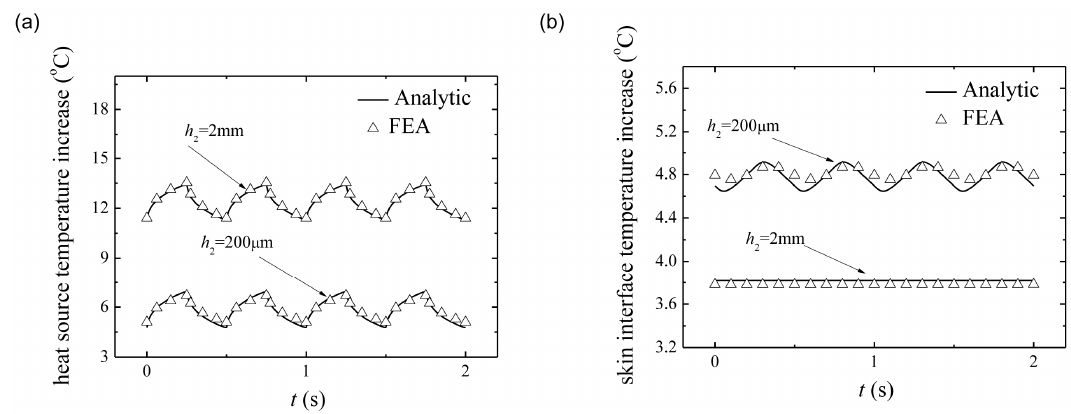
Figure 5. Temperature increase comparison between the analytic prediction and finite element analysis for the pulsed peak power density 2500 W/m 2 with 50% duty cycle and period 500 ms: ( a ) heat source; and ( b ) skin surface.